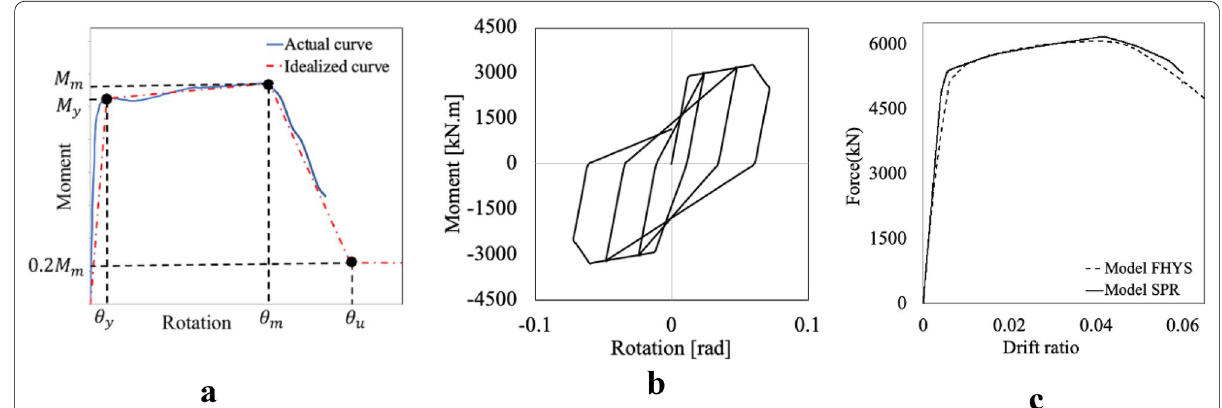
Fig. 5 a Schematic trilinear moment–rotation relationship for rotational springs. b Simulated cyclic response. c Comparison of pushover curves of frame using fiber sections versus concentrated